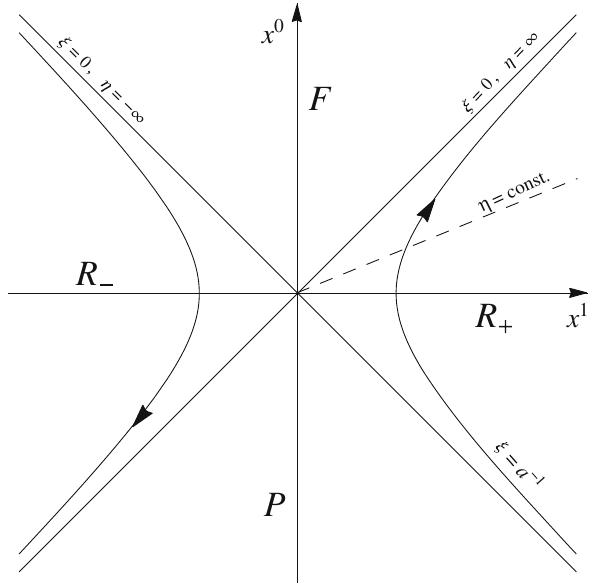
Fig. 1 The proper coordinate system of a uniformly accelerated observerintheMinkowskispacetime.Thebranchofhyperbola ξ = a − 1 represents the worldline of an observer with proper acceleration